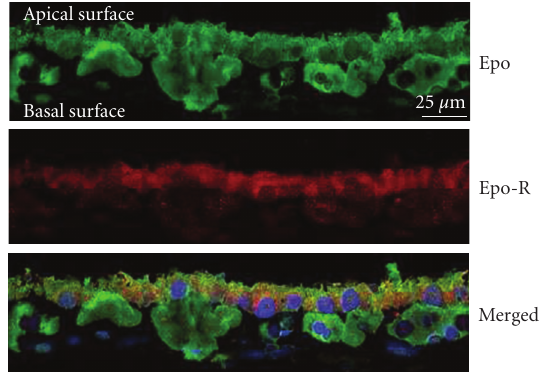
Figure 3: Confocal microscopy of human RPE showing the expression of both erythropoietin (Epo) in green and Epo receptor (Epo-R) in red. At the bottom the merged image shows partial colocalization of Epo and Epo-R.